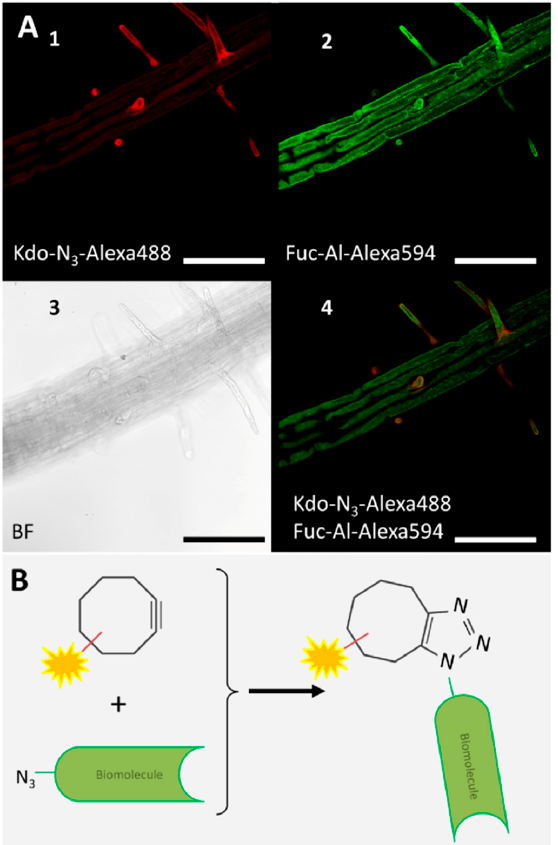
Figure 12. Click chemistry for in vivo plant labeling. ( A ) Double labeling of four day-old Arabidopsis seedlings incubated with 50 µM of Kdo-Azide (Kdo-Az) and 50 µM of Fucose-Alkyne (Fuc-Al) and successively labeled with Alexa Fluor ® 488-alkyne (red) and Alexa Fluor ® 594-Azide (green). (1) Elongation and differentiation zone observed with the A488 channel. (2) Same zone as in (1) observed with the A594 channel. (3) Bright-field image of the elongation zone. (4) Elongation zone observed with merged A488 and A594 channels. Scale bars: 100 µm. ( B ) Schematic representation of the copper-free bioorthogonal reaction between an azido-biomolecule and a